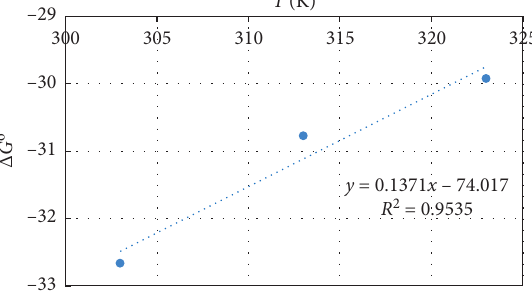
Figure 12: Plot of Gibbs free energy change, Δ G o , versus temperature ( T